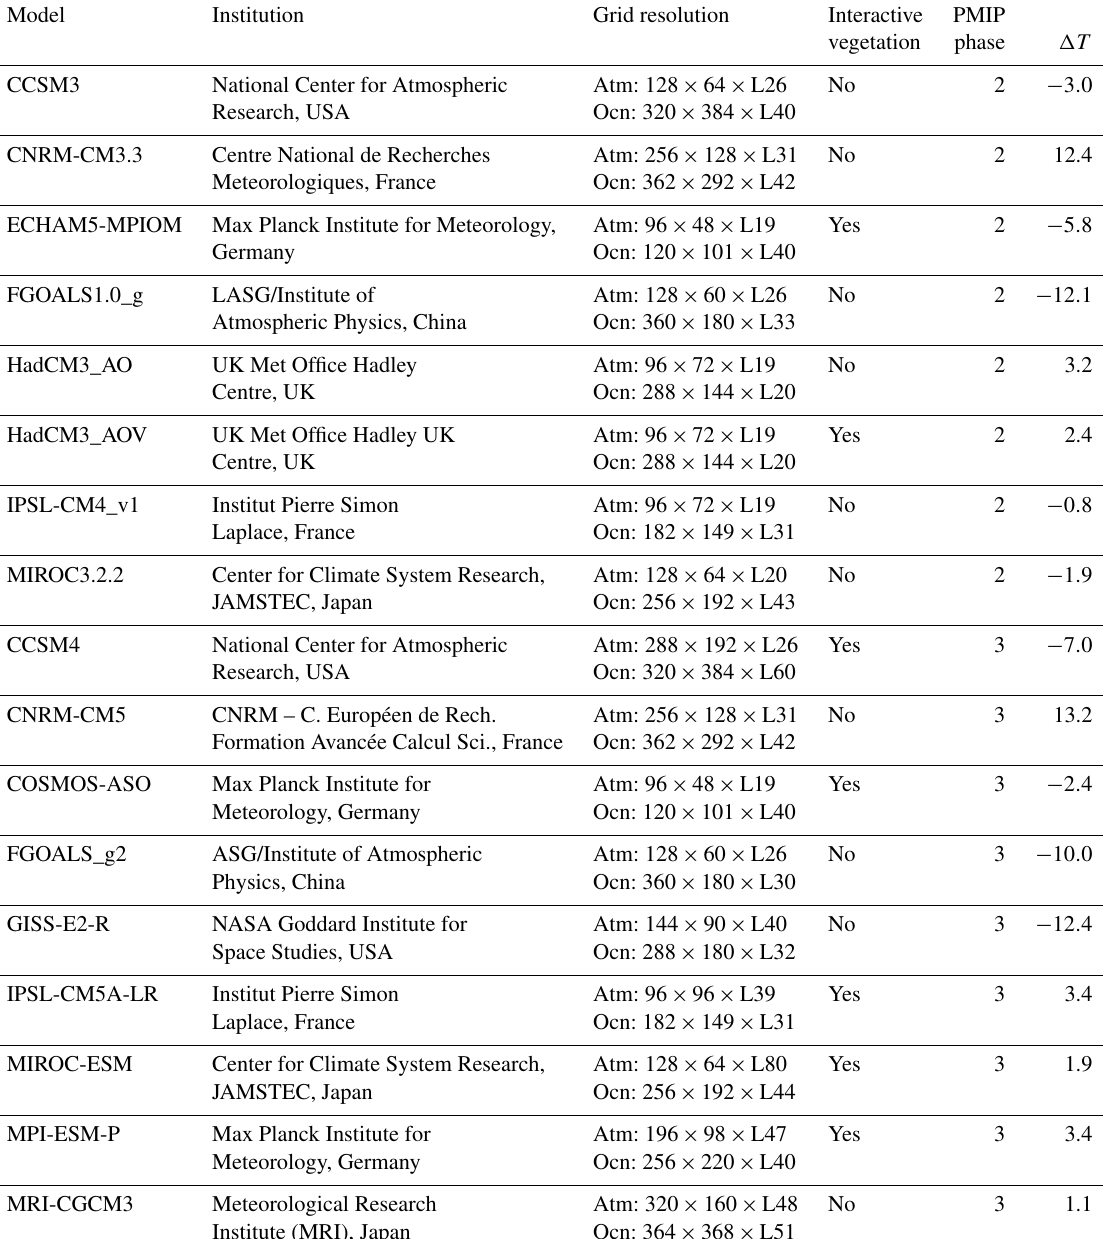
Table 1. List with PMIP2 and PMIP3 climate models included in the analysis with details on grid resolution and usage of interactive vegetation. In the last column, the simulated LGM June–July–August (JJA) surface temperature anomaly (K) in the Siberian target region with respect to the pre-industrial is given for reference. The following abbreviations are used: Atm (atmospheric grid resolution), Ocn (ocean grid resolution) and L (number of levels in the vertical). See https://pmip2.lsce.ipsl.fr (last access: 14 February 2020) and https://pmip3.lsce.ipsl.fr (last access: 14 February 2020) for further details and